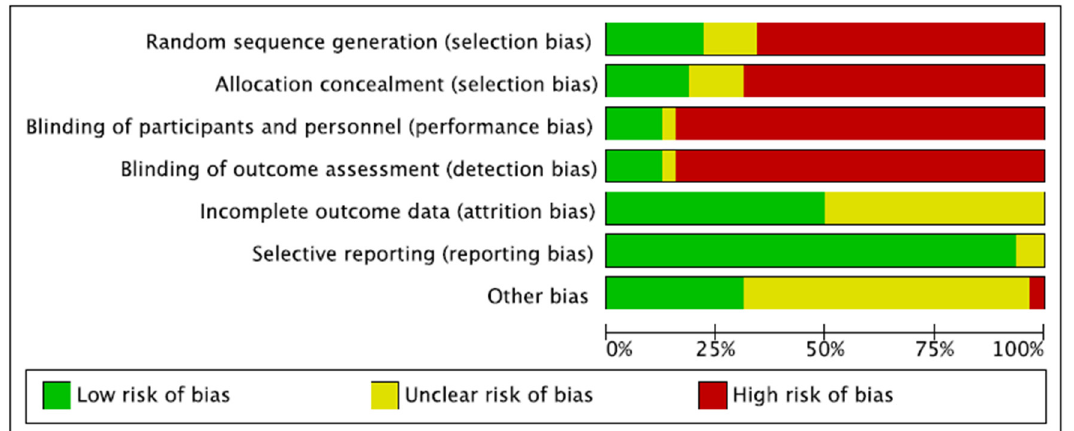
Figure 1. Flow chart of the literature search.